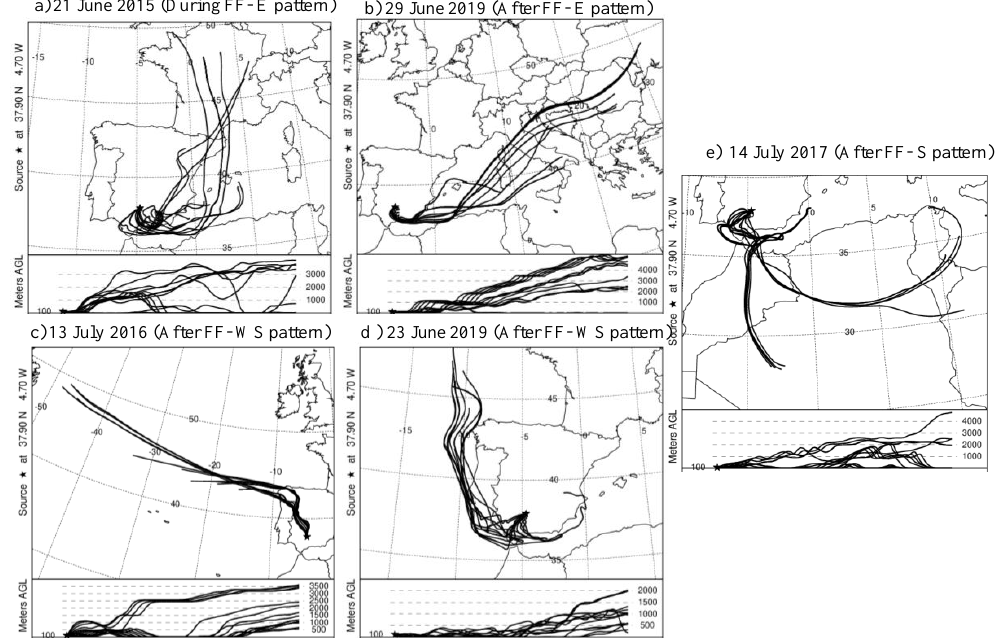
Figure 5. Daily 96-h backward trajectories in Cordoba at 100 m during ( a ) 21 June 2015 and after ( b ) 29 June 2019, ( c ) 13 July 2016, ( d ) 23 June 2019 the Castanea pollen periods above the 90th percentile, and ( e ) under the arrival of air masses from north Africa (14 July